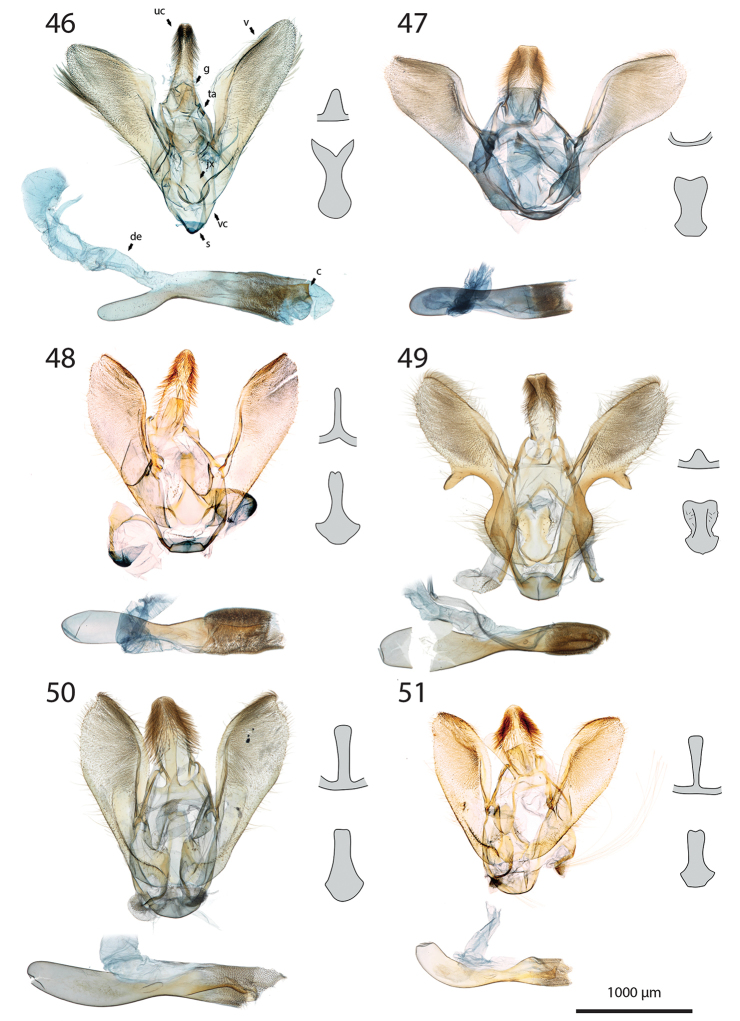
Male genitalia features of Hoploscopa. For each figure left above: genitalia without phallus; left below: phallus; right above: gnathos drawing; right below: juxta drawing. 46Hoploscopa
albipuncta sp. nov., paratype, TL336 ♂ (genitalia without phallus), TL635 ♂ (phallus) 47Hoploscopa
matheae sp. nov., paratype, TL730 ♂ 48Hoploscopa
sepanggi sp. nov., paratype, TL641 ♂ 49Hoploscopa
cynodonta sp. nov., paratype, TL531 ♂ 50Hoploscopa
parvimacula sp. nov., holotype, TL510 ♂ 51Hoploscopa
kinabaluensis sp. nov., paratype, TL342 ♂. Abbreviations: c (cornutus), de (ductus ejaculatorius), g (gnathos), jx (juxta), s (saccus), ta (tegumen arm), v (valva), vc (vinculum), uc (uncus).